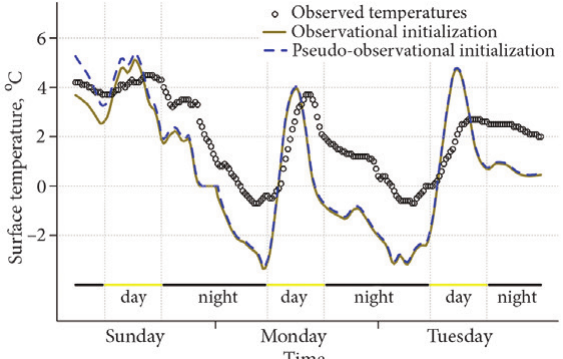
Fig. 6. Comparison of the pavement surface temperature and the METRo forecasts for observational and pseudo- observational initializations